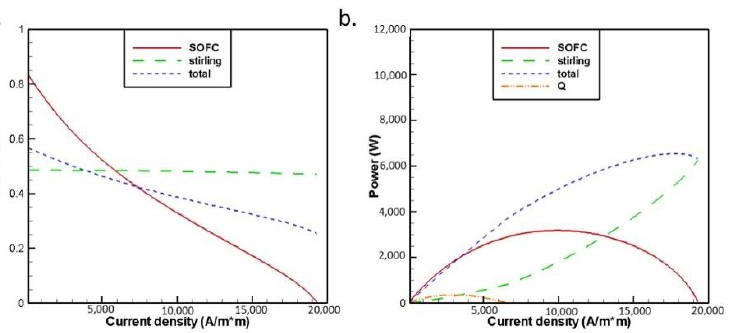
Figure 11. Computed ( a ) efficiency and ( b ) generated power at different current densities at 1173 K for the optimized design loop.